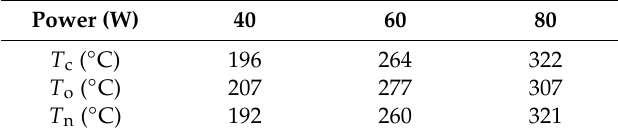
Table 2. The temperature at di ff erent power tested by di ff erent methods.